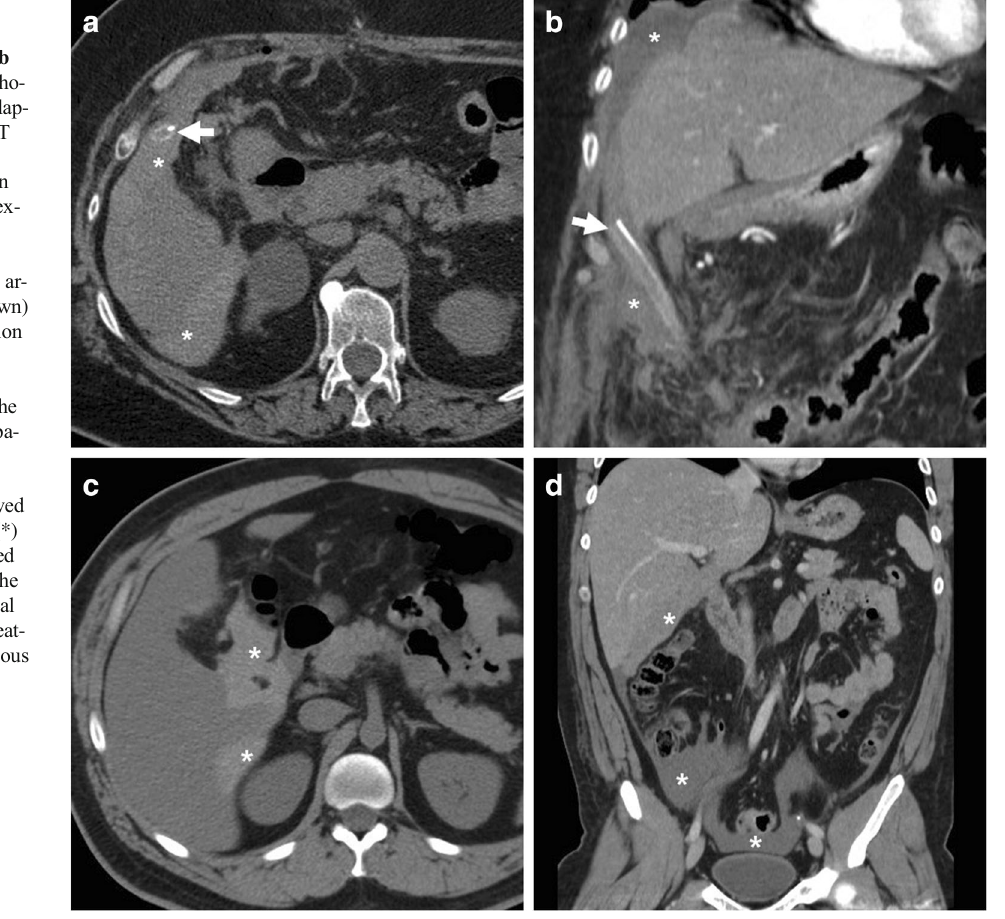
collection consistent with empyema (*) along the postero-lateral aspect of the right liver lobe, which was treated with percutaneous drainage (not